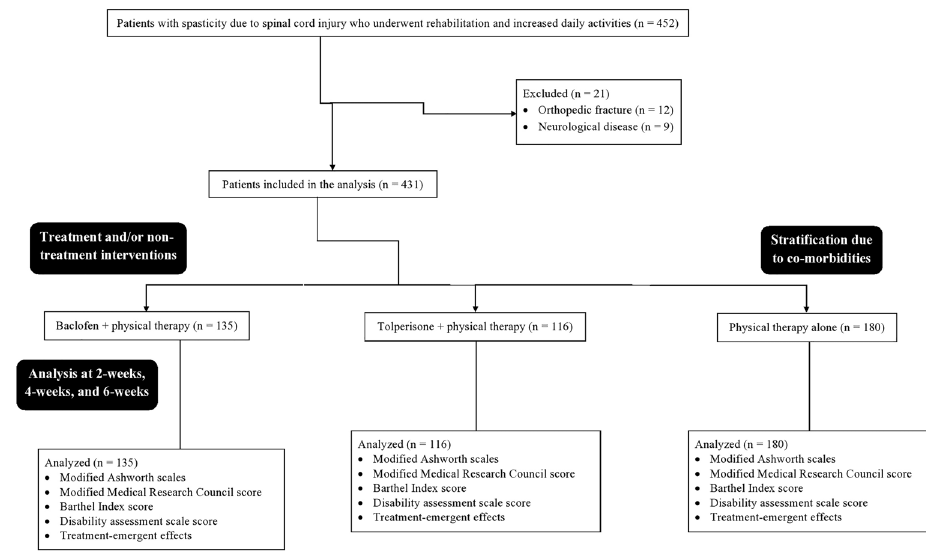
Figure 1. The fl ow diagram of management of